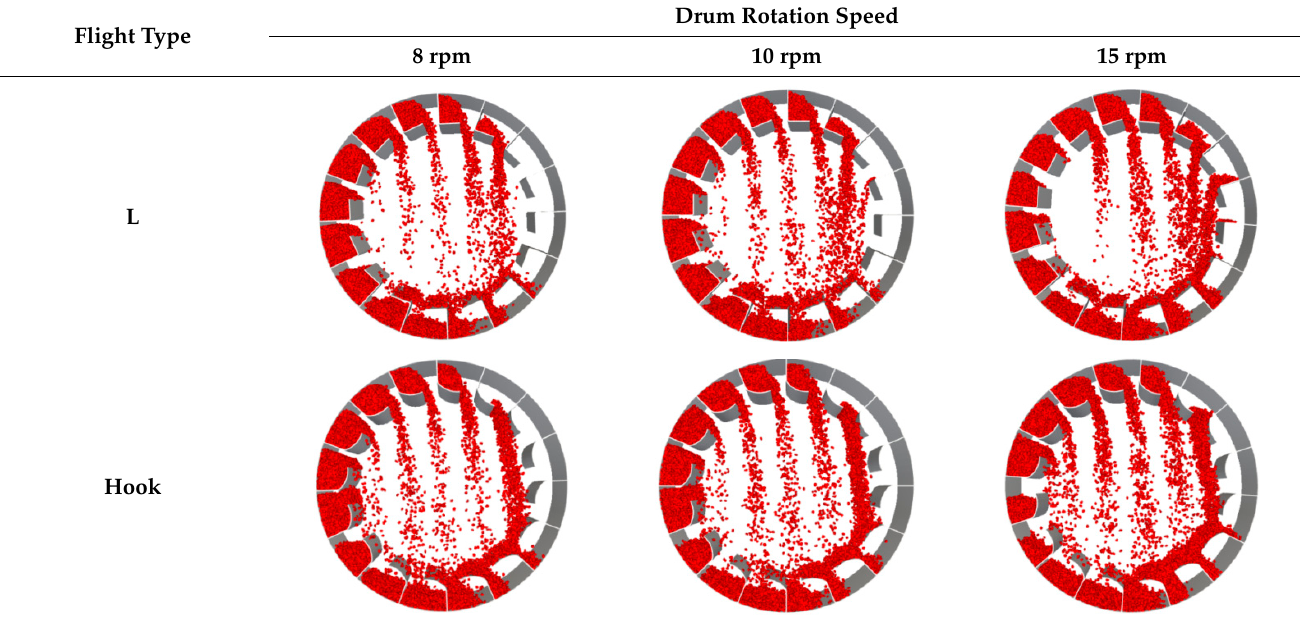
Table 6. The image of the particle dispersion mode for different flights shape and 15% drum filling